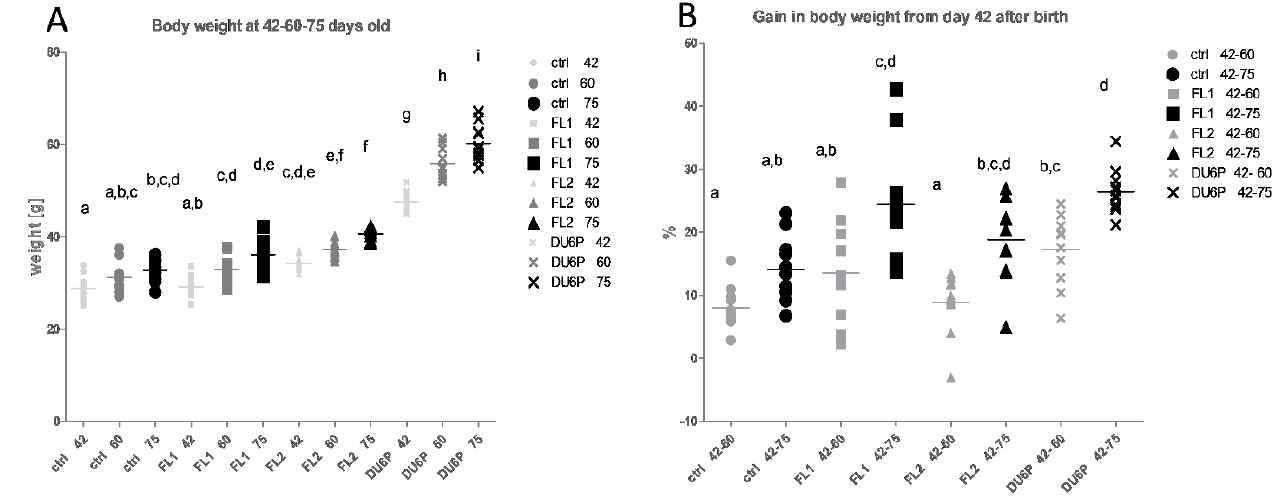
Figure 1. ( A ) Mouse weights in grams in control (circles), FL1 (squares), FL2 (triangles) and DU6P (crosses) at 42–60 and 75 days old. Each line is represented using the same symbol, and each age in different tonalities and dimensions, starting from the lightest/smallest (42 days old) and finishing with the darkest/largest (75 days old). ( B ) Gain in body weight in control (circles), FL1 (squares), FL2 (triangles) and DU6P (crosses) from 42 days old to 60 days old (clear color) and from 42 to 75 days old (dark color). Data are illustrated as the mean ± SEM (standard error of the mean) and designated significant if p < 0.5 (Tukey posttest: different letters correspond to different levels of significance).